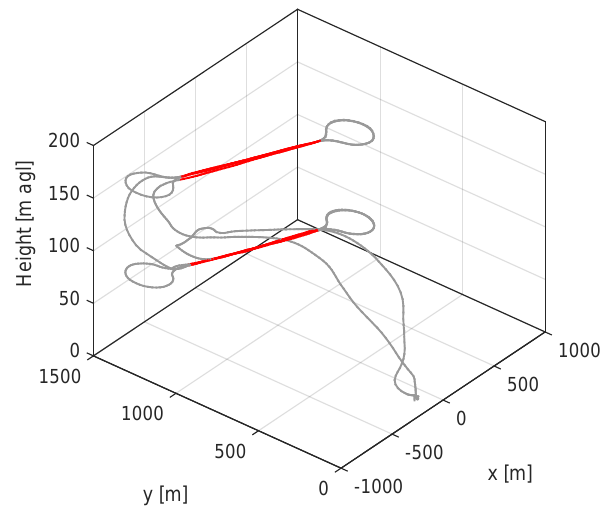
Figure 5. Typical flight pattern for the turbulence measurements during the BLLAST campaign. Turbulence data are only evaluated for the straight flight legs coloured in